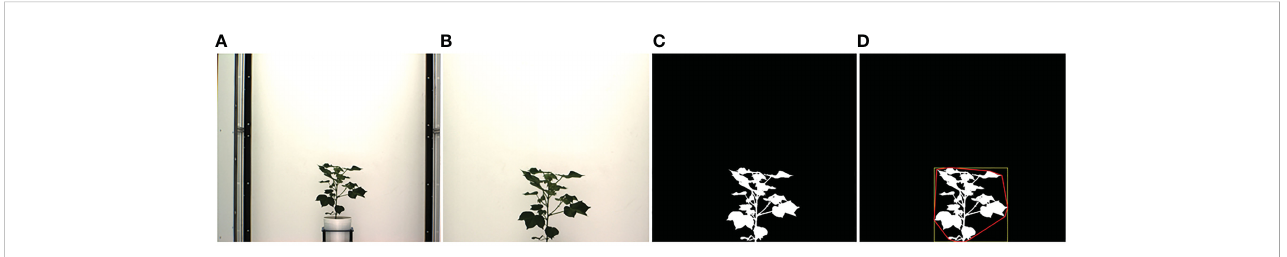
FIGURE 1 Illustration of holistic phenotype computation based on image analysis: (A) original image; (B) cropped image; (C) binary image; (D) plant enclosed by bounding rectangle and convex hull.